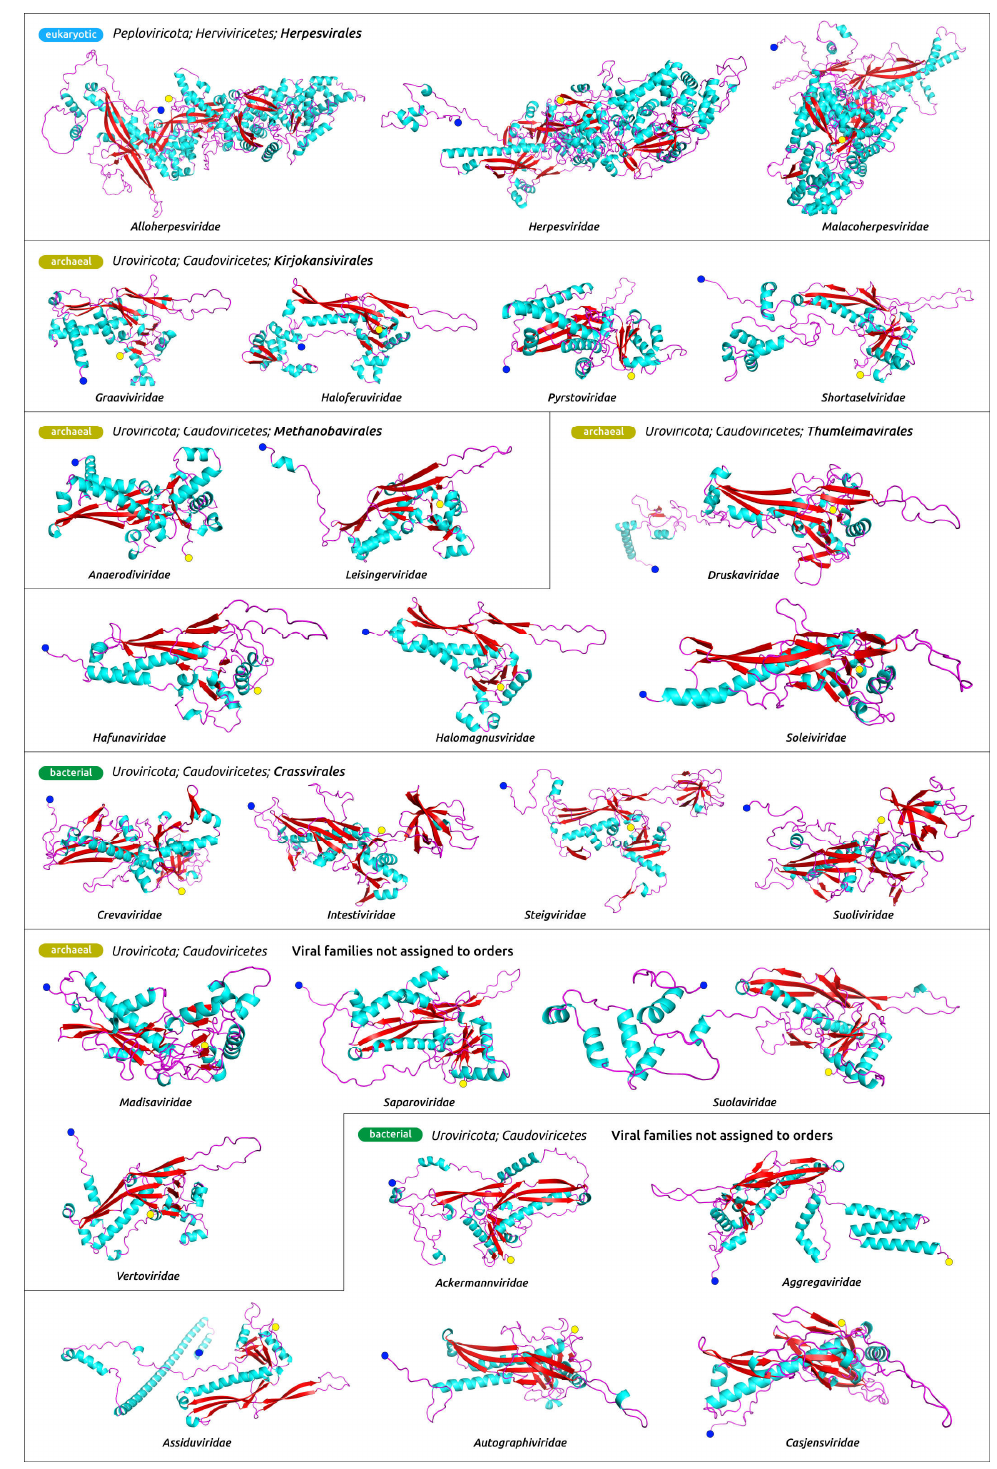
Figure 2. Structural models of the product of the whole genes encoding for the major capsid proteins in the genomes of representative viruses (Table 1), obtained with AlphaFold. The N-terminus is labelled with a blue circle and the C-terminus is labelled with a yellow circle. Other predicted MCP structures are shown in Supplementary Figure S2.